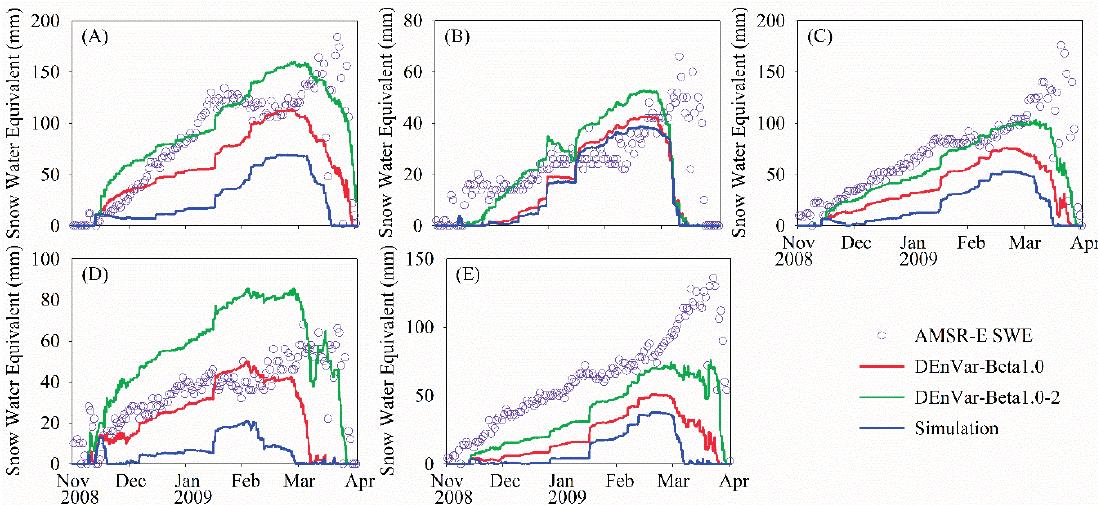
Figure 11. Graphical representation of the SWE state. Cf . Figure